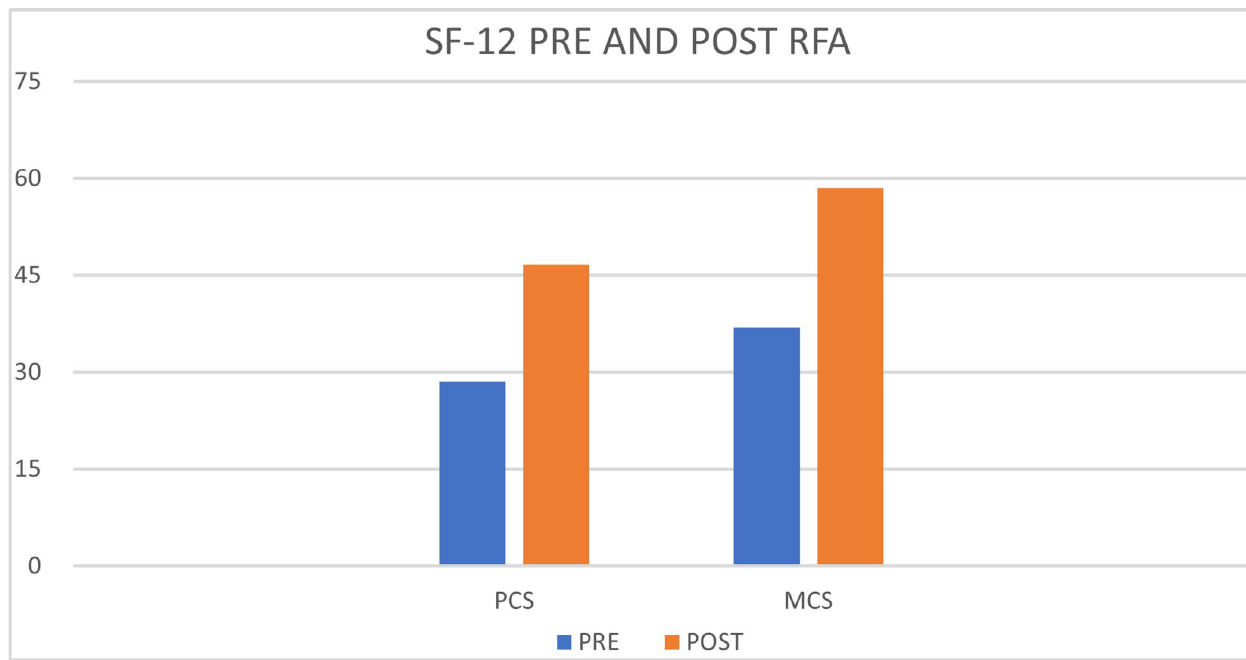
Figure 3. SF-12 Pre and Post RFA. SF-12 questionnaire, Physical Component Score (PCS) and Mental Component Score (MCS).